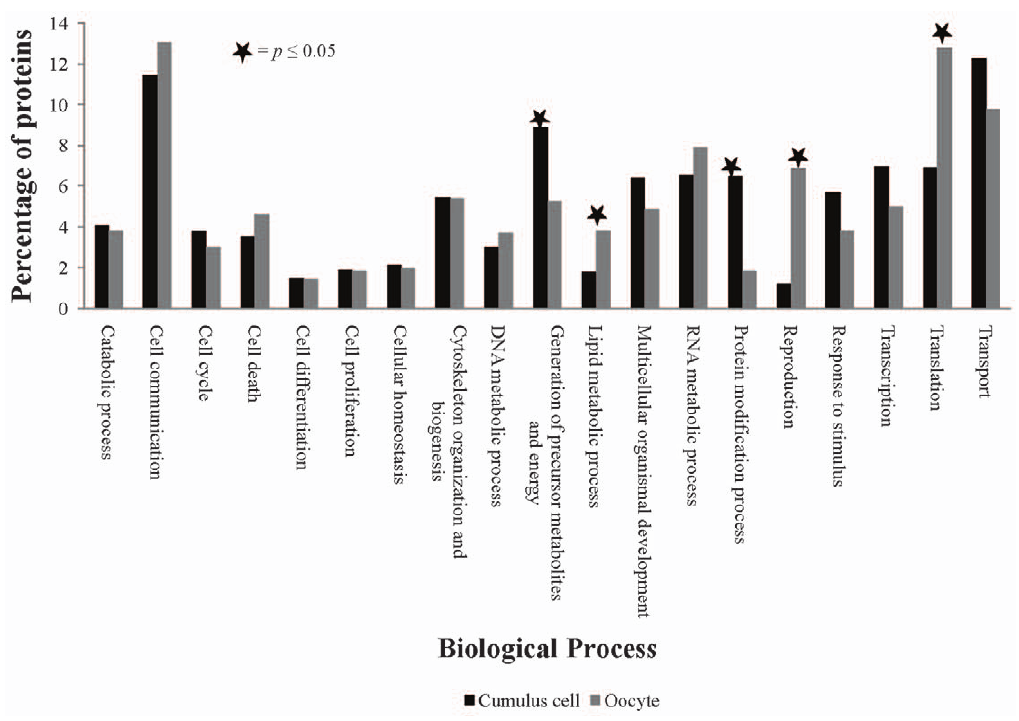
Figure 3. Gene Ontology (GO) modeling of germinal vesicle (GV) oocyte and cumulus cell proteomes. Distribution of percentages of GV stage oocyte and cumulus cell proteins involved in various biological processes. Significant differences in percentage of proteins involved in various